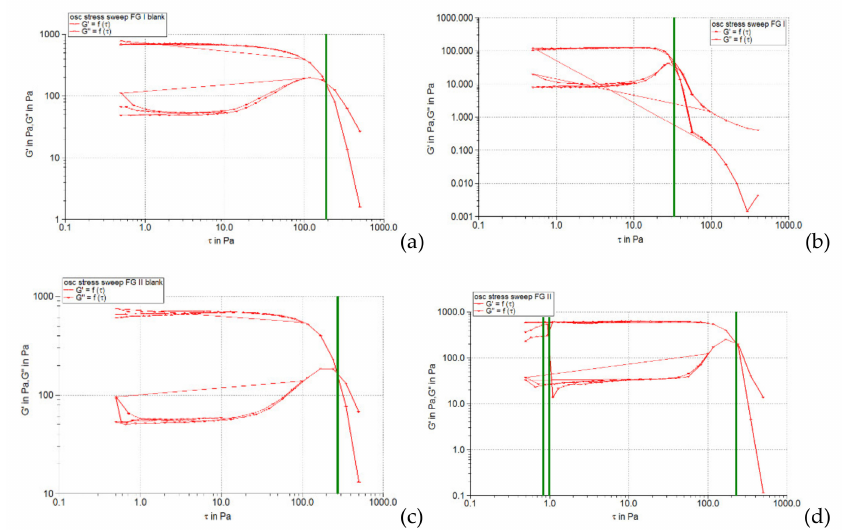
Figure 1. The behavior of viscoelastic modules G’ and G” depending on the shear stress for hydrogels based on Carbopol 940 and glycerol, simple or loaded with caffeic acid liposomes: ( a ) FGI blank, ( b ) FGI, ( c ) FGII blank, ( d )